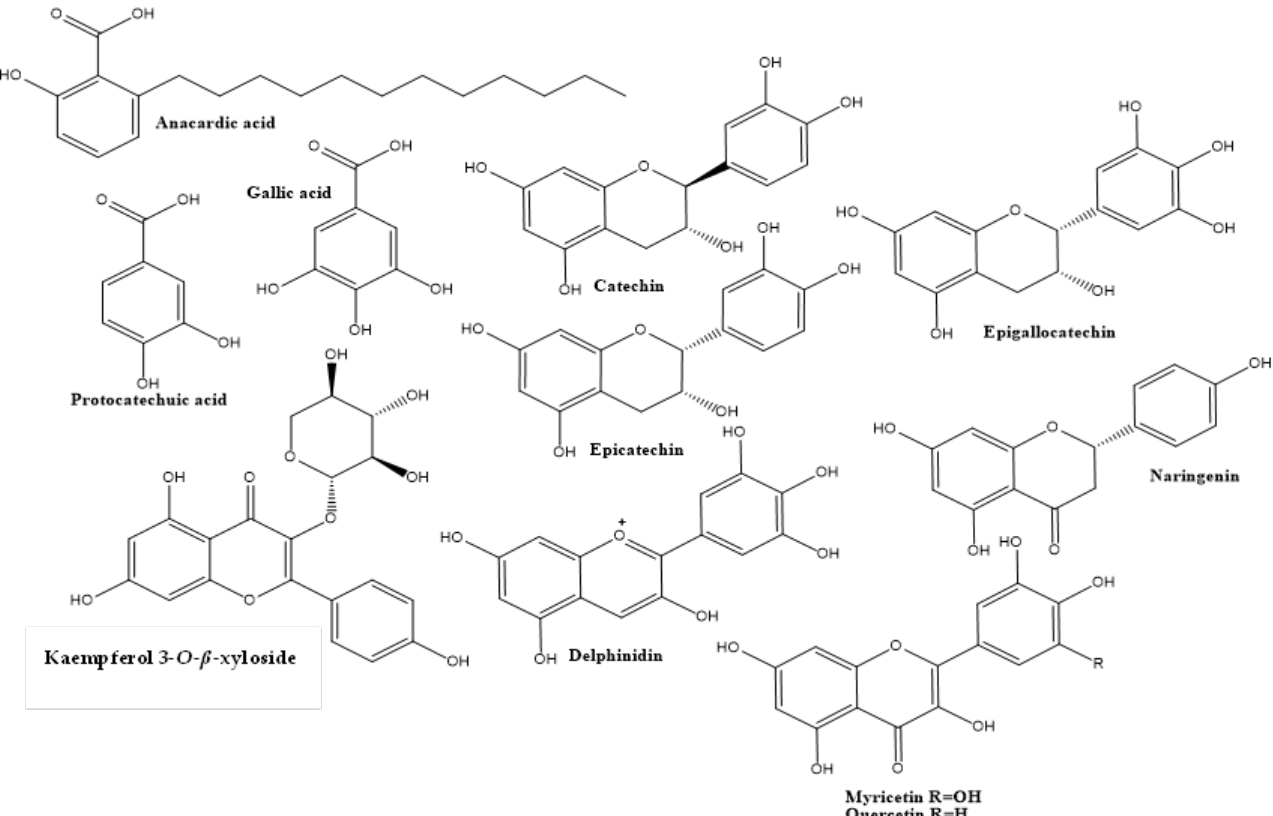
Figure 3. Chemical structures of bioactive phytocompounds with reported antidiabetic properties identified in Anacardium occidentale L.